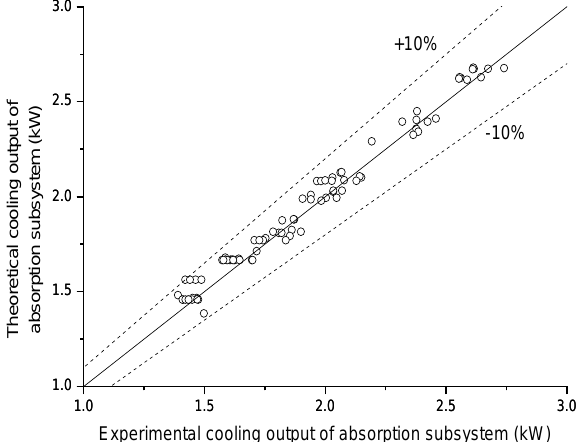
Figure 4. Model validation of absorption subsystem. Table 1. Model validation of compression subsystem.